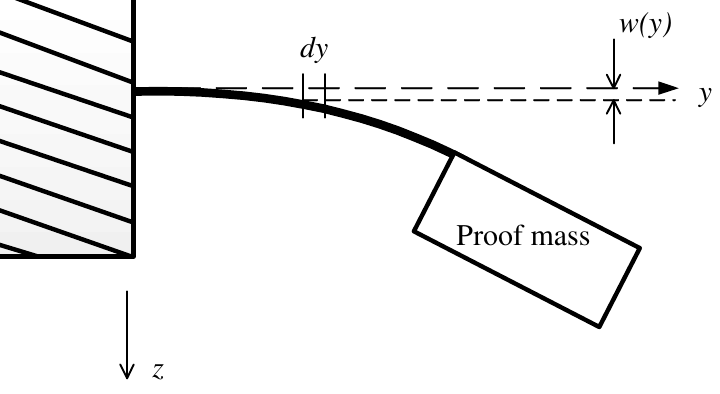
Figure. 3. Illustrative deformation of the sensing structure subject to a downward acceleration.